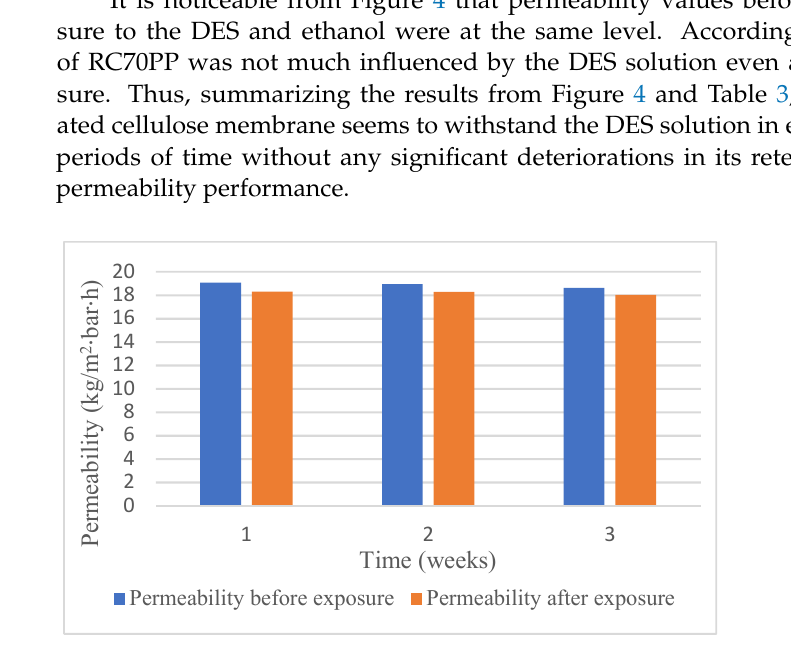
Figure 4. Permeabilities of RC70PP membranes exposed to 60 vol% fresh DES in ethanol for three time periods: 1 week, 2 weeks, 3 weeks. Table 3. Total carbon retentions of the membranes exposed to 60 vol% fresh DES in ethanol meas- ured with PEG (4 kDa) solution of 300 ppm.